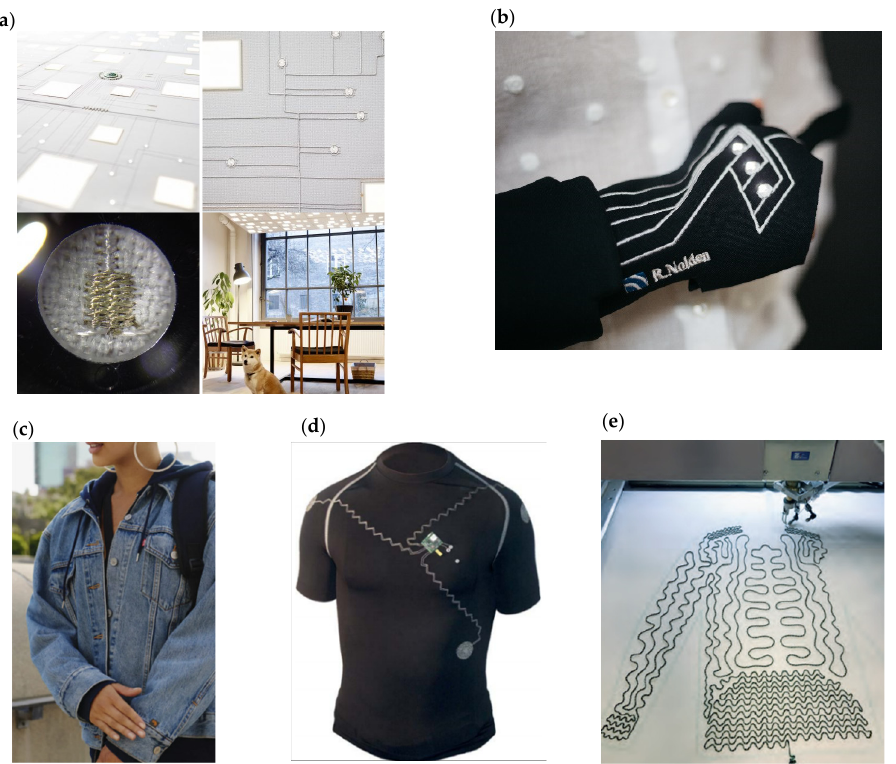
Figure 1. ( a ) Embroidered light for acoustic ceilings [6] ( b ) Smart glove [8] ( c ) Jacquard Trucker Jacket Levi’s ® [4] ( d ) EKG shirt with embroidered electrical interconnections [7] ( e ) Embroidered heating jacket [11].